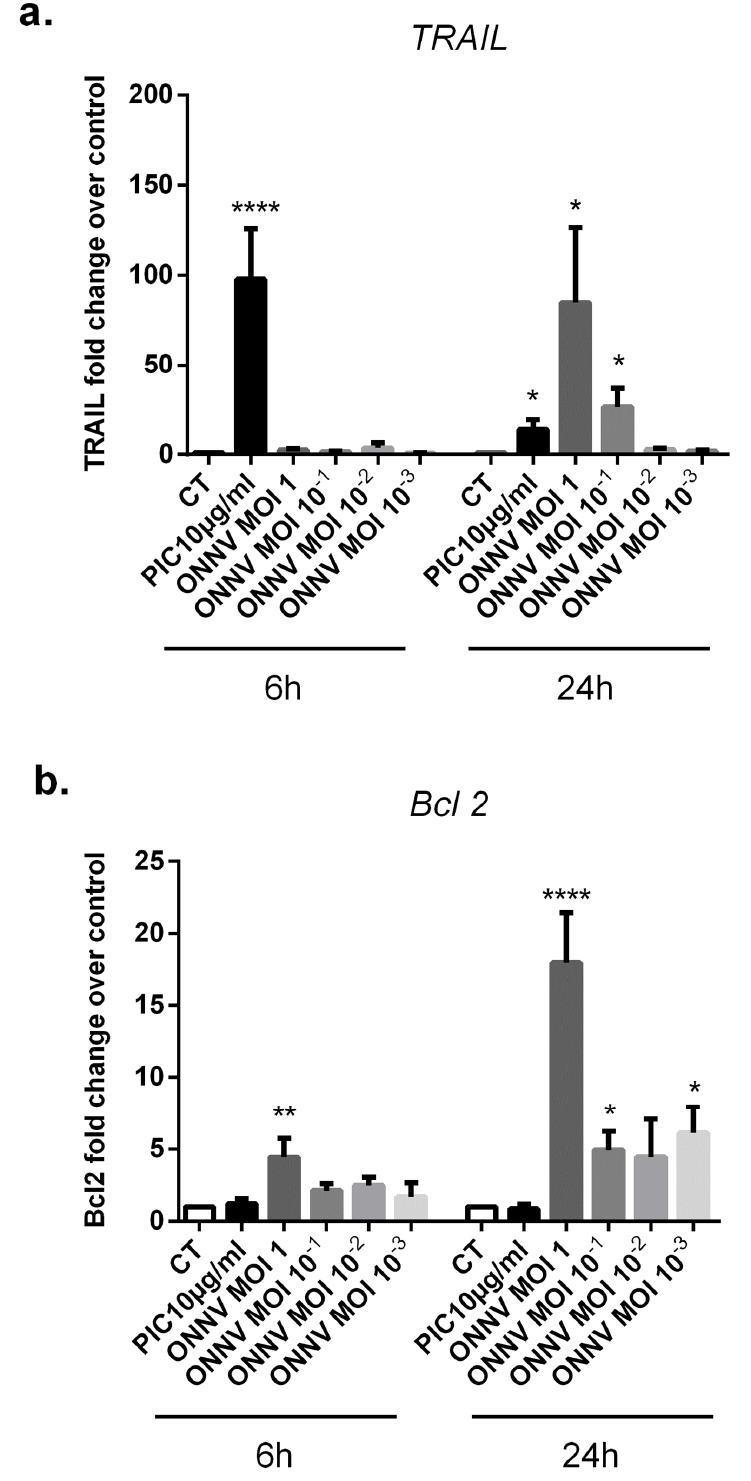
Figure 11. SC upregulate TRAIL and Bcl 2 mRNA expression in response to ONNV infection. ( a ) TRAIL and ( b ) Bcl 2 mRNA levels were assessed by qRT-PCR in SC infected by ONNV (MOI 10 − 3 to 1) or exposed to PIC 10 µ g/mL for 6 h and 24 h. All experiments were done in triplicates. Results are expressed as mean ± SEM and presented as a normalized fold increase vs. control. * p -values ≤ 0.05, ** p -values ≤ 0.01, and **** p -values ≤ 0.0001 represent significant differences from controls by one-way ANOVA followed by the Bonferroni’s test